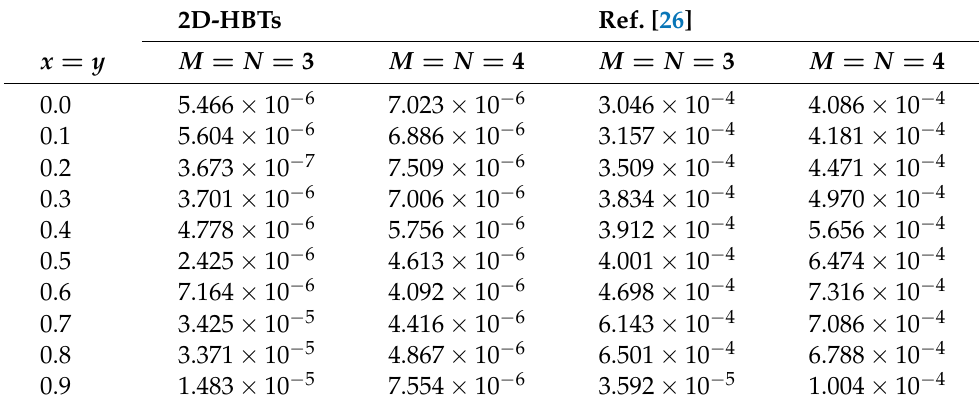
Table 2. The maximum norm errors of Example 2.